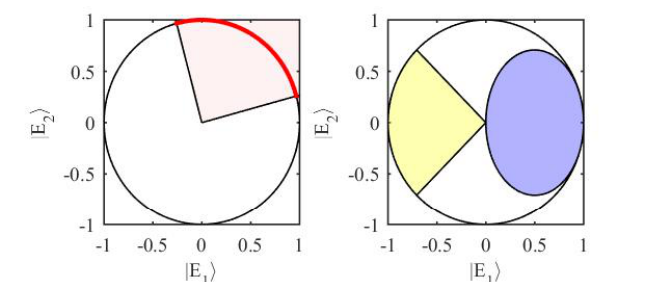
Figure 3. Left) We start with C 2 and choose two random orthogonal vectors in this space. This spans a real subspace R 2 , and positive superpositions of the two vectors form a self-dual cone. The red circle arc is the unit normalized part of the self-dual cone. Right) The three dimensional analogue, where we show the upper hemisphere and the self-dual orthant (yellow) and circular (blue)